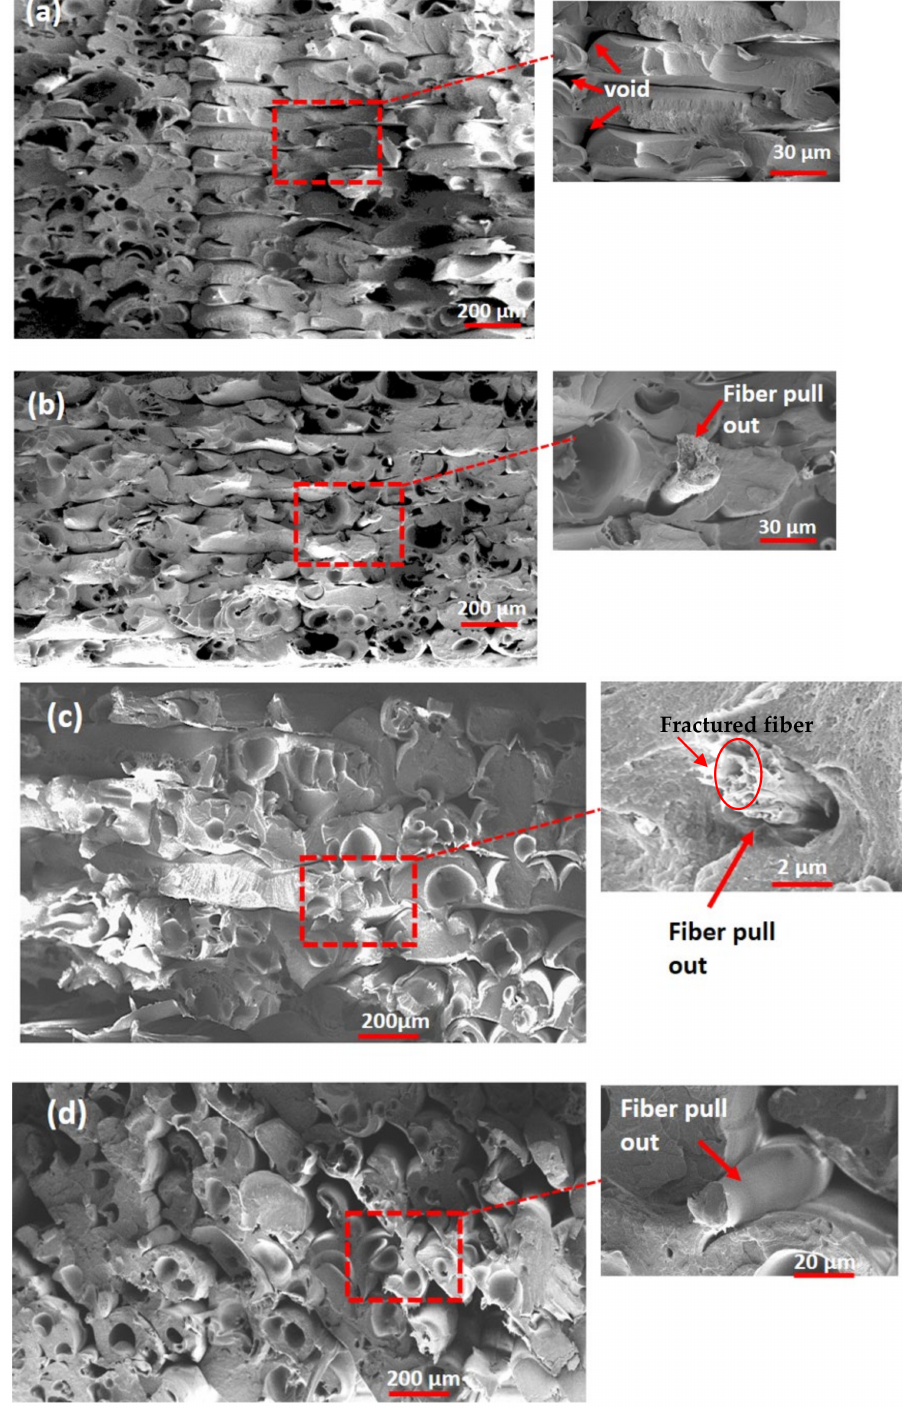
Figure 9. SEM images of ( a ) S1 ( b ) S4 ( c ) S7 and ( d ) S8 specimens with fractured